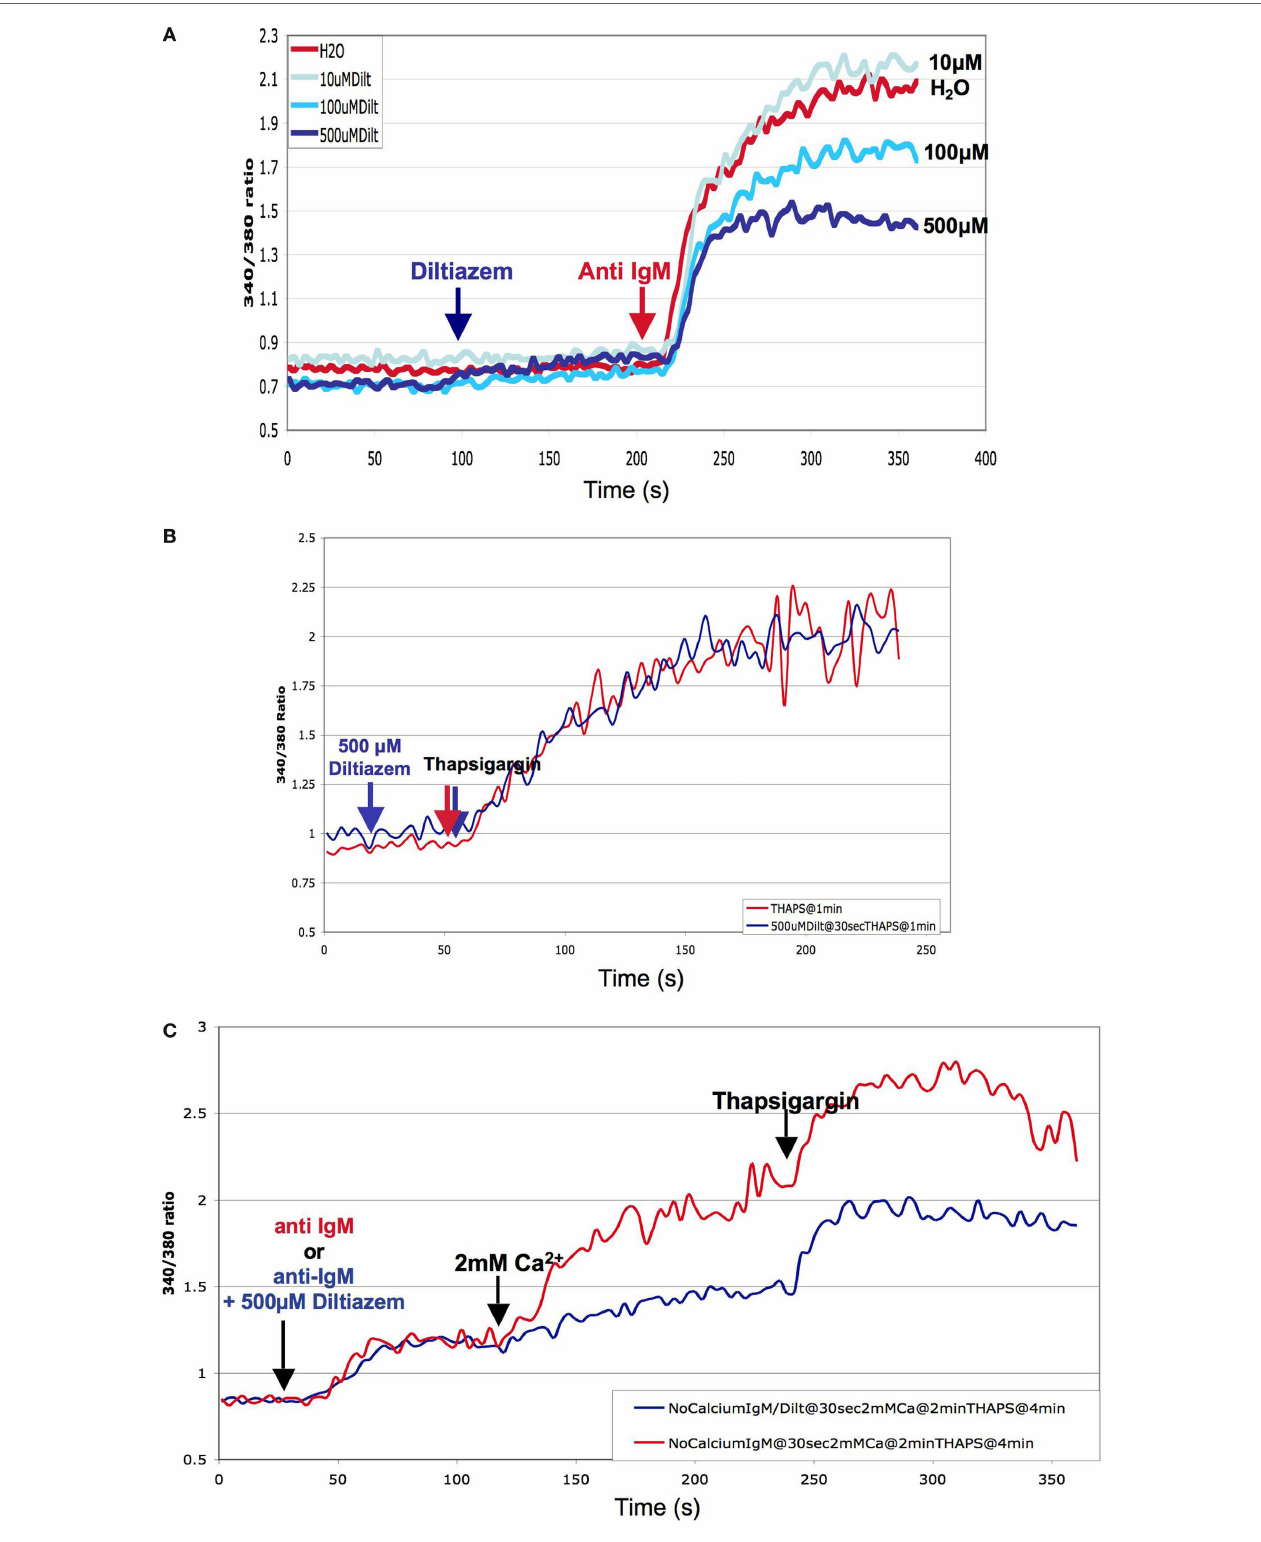
FiGUre 3 | pharmacological inhibition of BCr-mediated Ca 2 + -response by the L-type channel blocker diltiazem: dt40 cells were loaded with the fluorescent Ca 2 + -dye Fura-2 and the cells stimulated either through the addition of chicken anti-igM (BCr-ligation) or thapsigargin (pharmacological store-depletion) into the